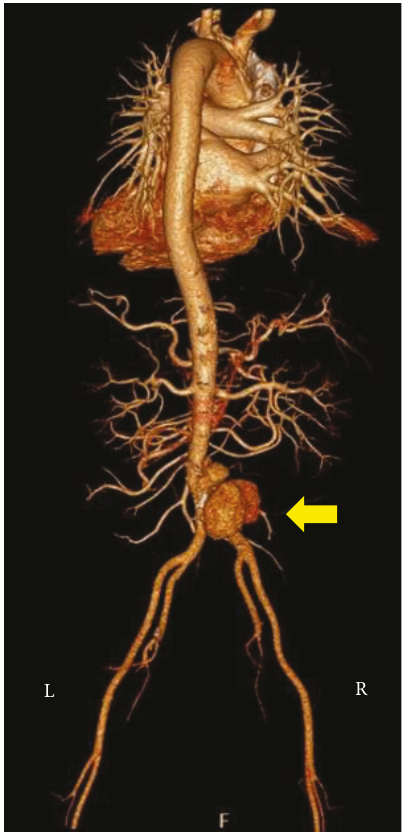
Figure 1: This is a 3-dimensional reconstruction of the CT aortogram, with the arrow indicating the saccular component of the